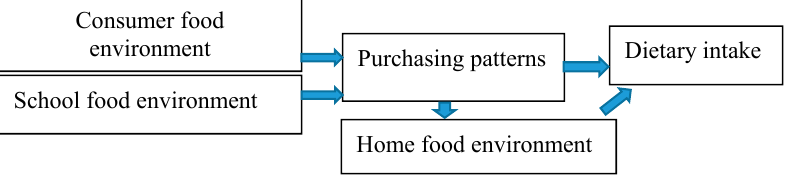
Figure 1. Conceptual model of pathways between food purchasing patterns, the home, school, and consumer food environments, and dietary intake.